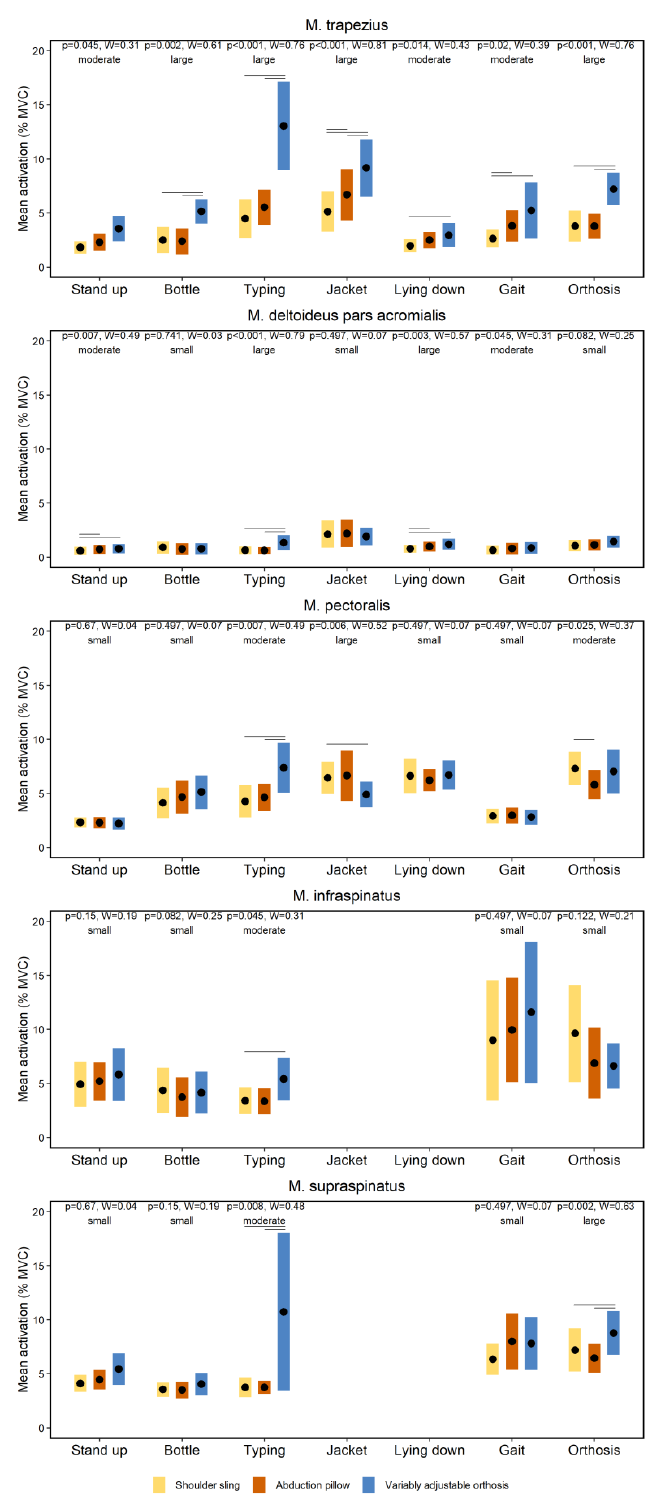
Figure 3. Effects of the orthoses on the neuromuscular activity of the shoulder muscles during the activities of daily living. Note: Diamonds and bars indicate mean activations (%MVC) and 90% confidence intervals, respectively. Horizontal lines indicate significant post-hoc effects. Data of the infraspinatus and supraspinatus muscles during two movement tasks (jacket and lying down) could not be analyzed due to movement artefacts within the fine-wire